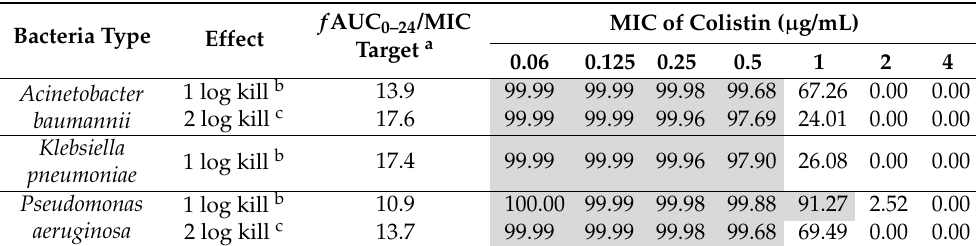
Table 2. Probability of target attainment (PTA) for colistin in terms of f AUC 0–24 /MIC after a CMS dose of 2.5 mg/kg CBA every 12 h for 7 consecutive days.